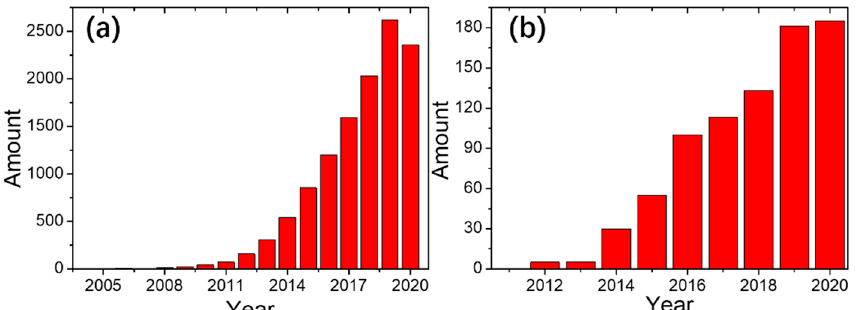
Figure 1. ( a ) Publications since 2004 retrieved by searching “carbon dots” or “carbon nanodots” or “graphene quantum dots” on Web of Science in November 2020; ( b ) publications since 2010 by refining the obtained result with “citric acid”.